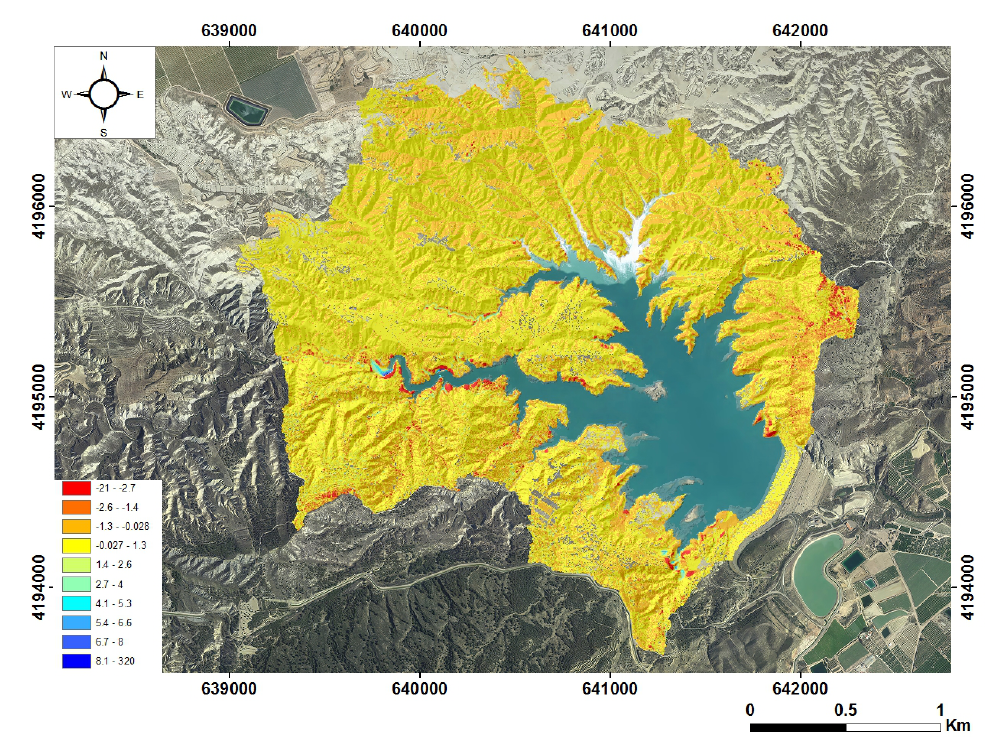
Figure 13. DoD in the lakeshore area for the survey PNOA 2009 and PNOA 2016.